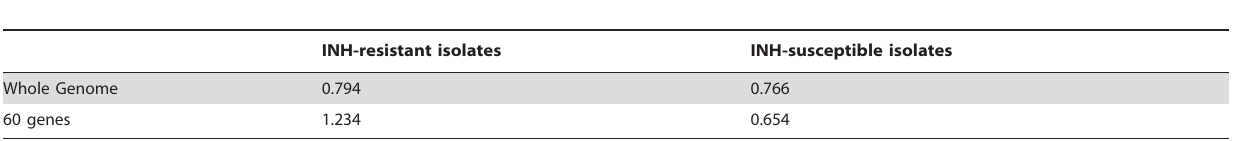
Table 3. The ratio of non-synonymous to synonymous mutations (dN/dS) in INH-resistant (n =12) and INH-susceptible (n=17) isolates, in (1) whole genome sequences and in (2) 60 INH-resistance associated